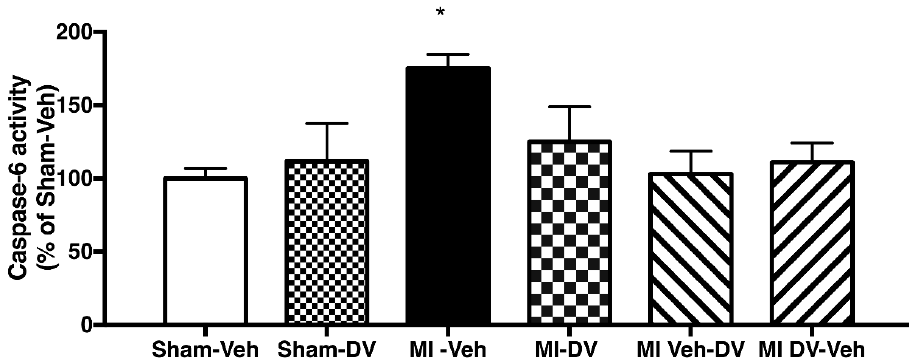
Figure 6. Caspase-6 activity in the CA1 region of the hippocampus 4 months after surgery. Caspase-6 activity in the CA1 region of the hippocampus is higher in vehicle-treated MI rats compared to any other group; caspase-6 activity is not different between DV-treated rats and vehicle-treated sham rats.; n = 6–8 per group (* p <